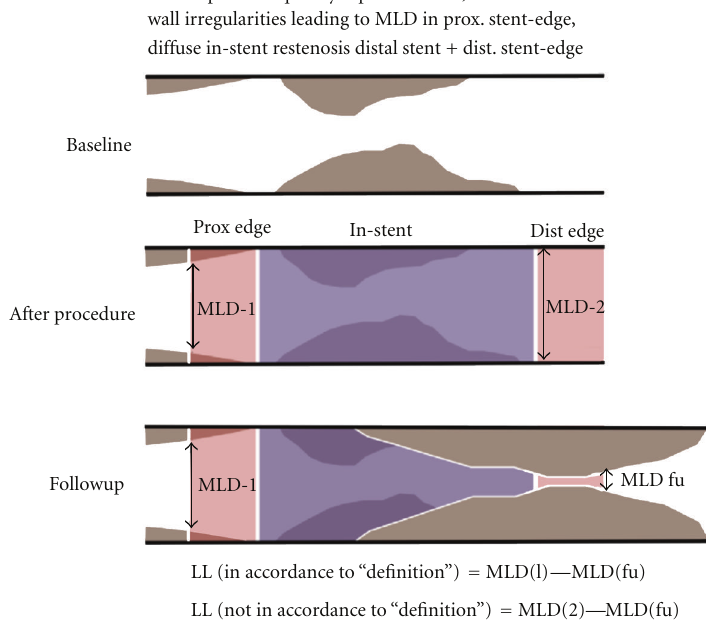
Figure 3: Erroneous late loss algorithm. Although the late loss ( = MLD-2 − MLD-fu) would reflect the enormous neointimal hyperplasia at the distal stent edge correctly (right red area), the erroneous algorithm/definition of late loss (in-segment) dictates to include the MLD from the opposite stent edge (MLD-1) (left red area) into the equation, leading to an inaccurate lower late loss (not reflecting the true amount of neointimal hyperplasia).